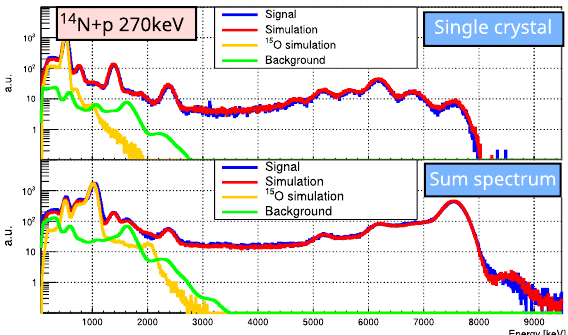
Figure 2. Comparison of simulated (red) and measured (blue) spectra of 14 N( p ,γ ) 15 O 270keV reso- nance. In green and yellow are represented environmental background and 15 O decay spectra respec- tively, included in the